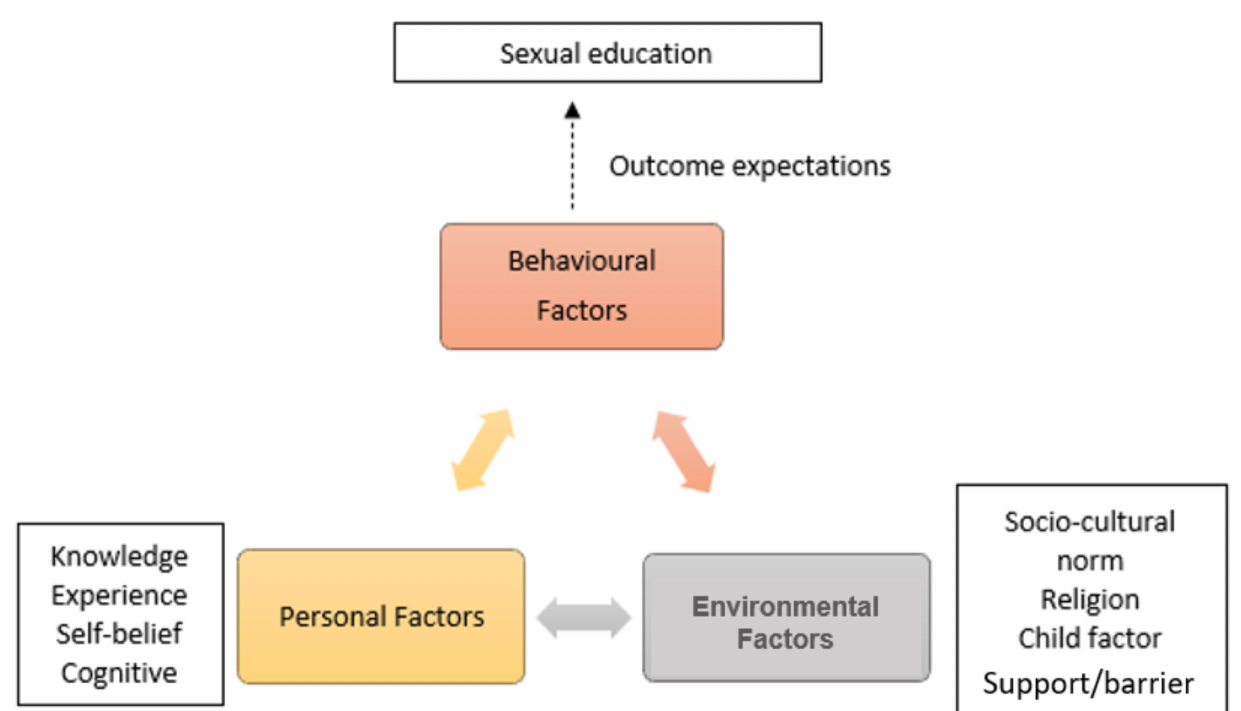
Figure 1. Bidirectional factors that influence mothers’ outcomes based on Social Cognitive Theory